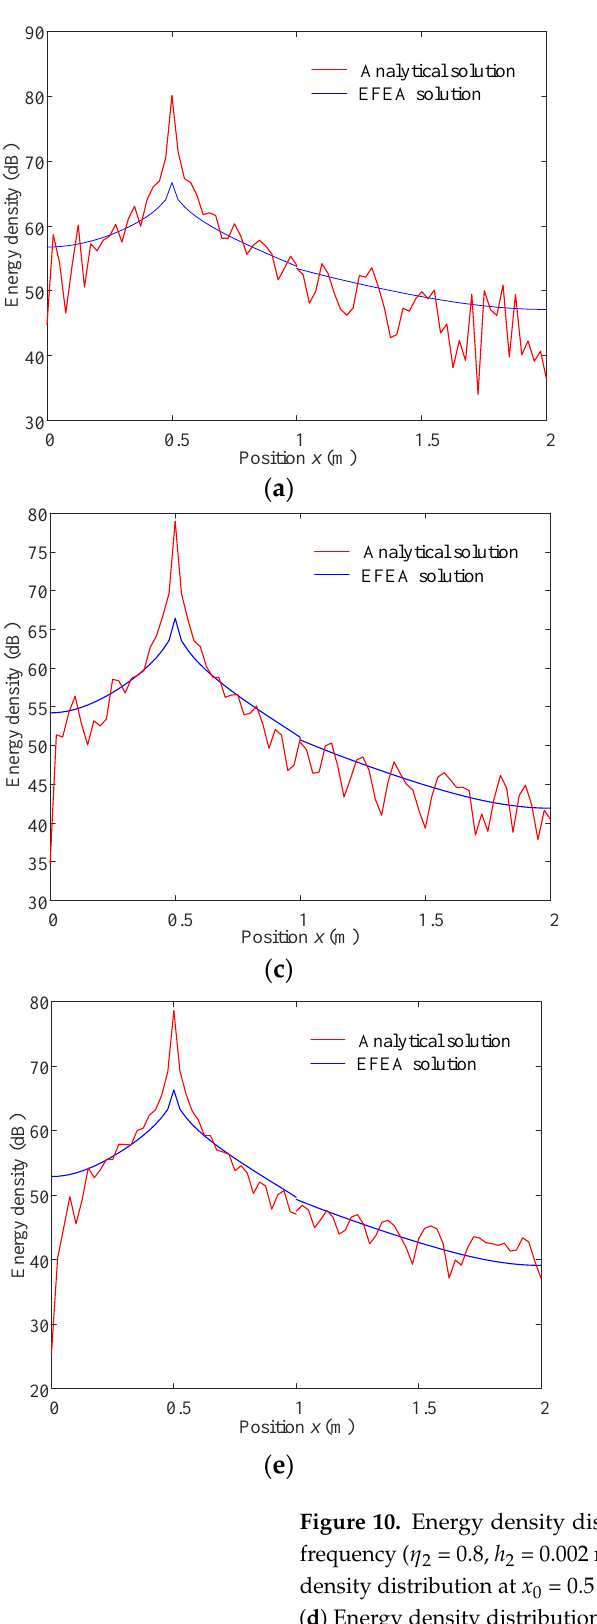
Figure 9. Energy density distribution for a plate with PFLD treatment ( f = 3 kHz, η 2 = 0.8, h 2 = 0.003 m). ( a ) EFEA solution. ( b ) Analytical solution. ( c ) Energy density distribution at y 0 = 0.5 m. ( d ) Energy density distribution at x 0 = 0.5 m.